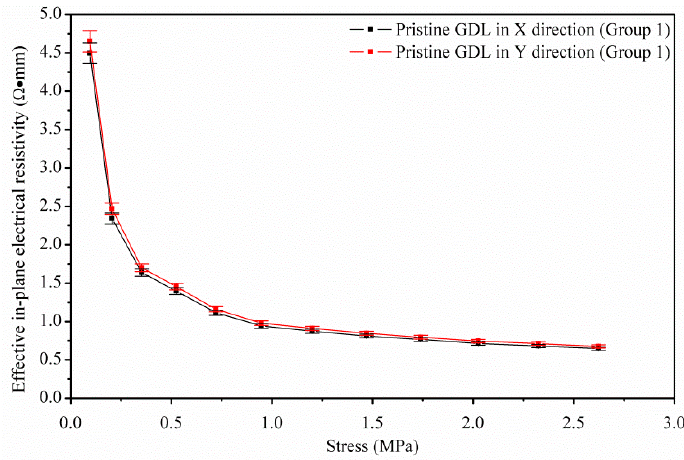
ff ective in-plane electrical resistivity vs. stress of pristine Figure 6. Effective in ‐ plane electrical resistivity vs. stress of pristine GDLs. Figure 6. E